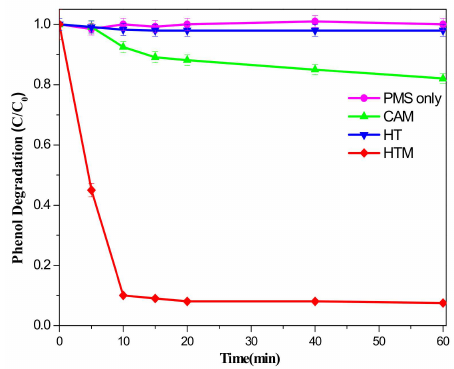
Figure 6. Chemical oxidation activity of di ff erent materials for phenol